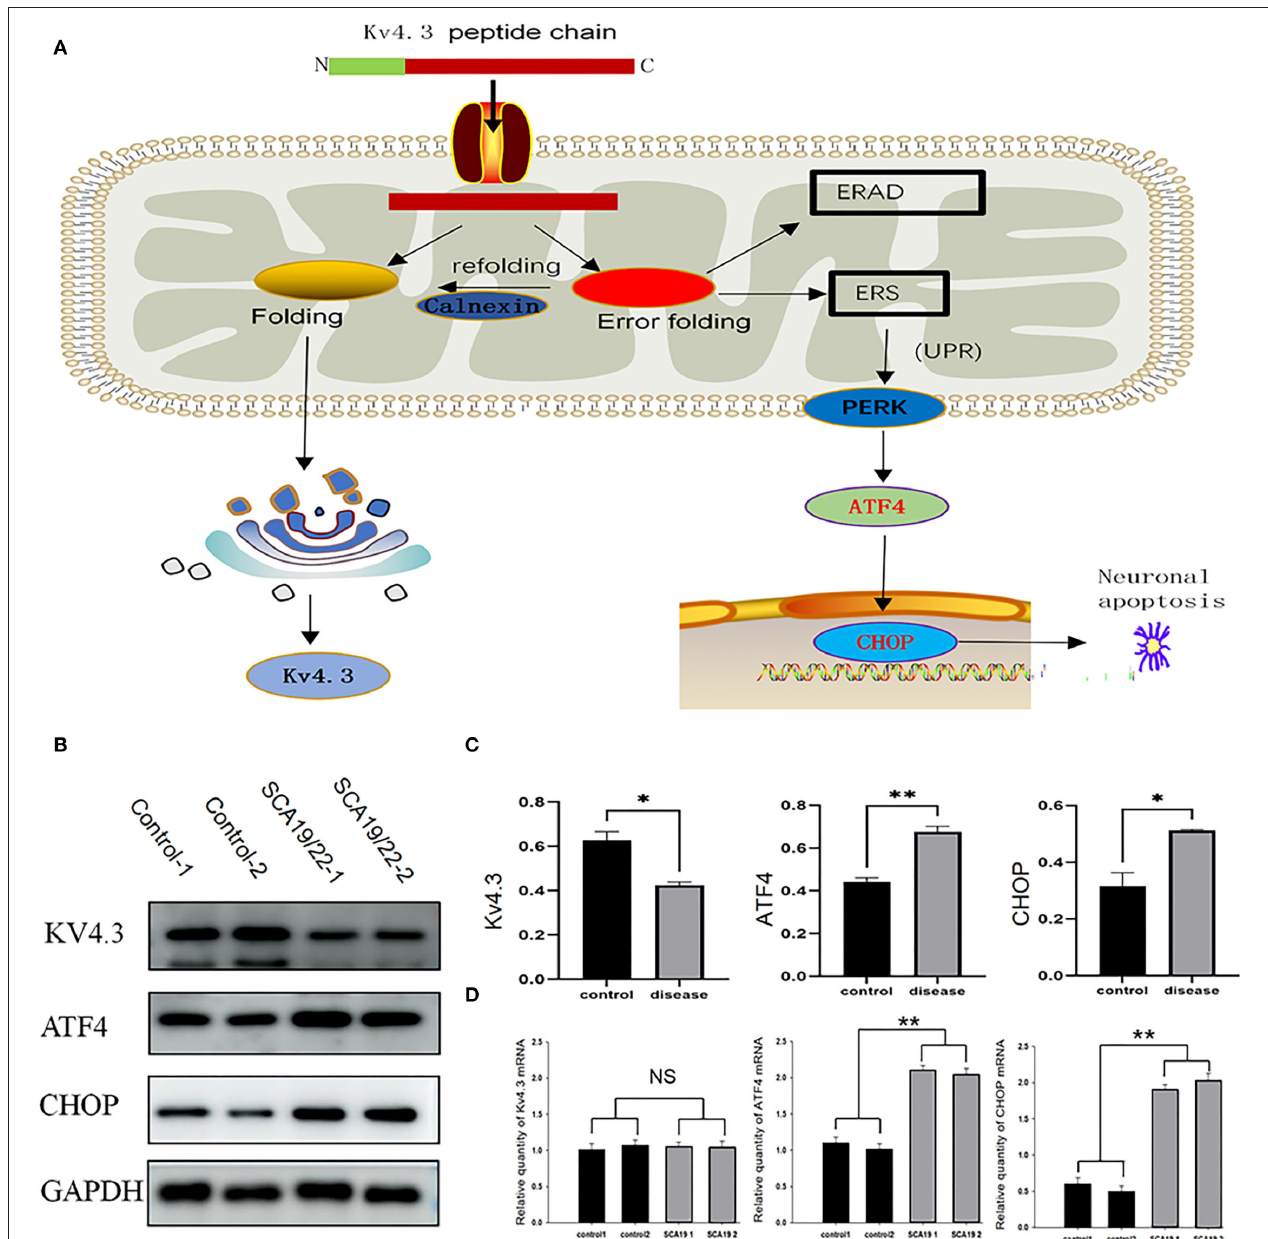
FIGURE 6 | (A) The mutant Kv4.3 instability increased and remained in the endoplasmic reticulum, which may activate the endoplasmic reticulum-associated degradation (ERAD) pathway and cause ERS. Increased expression of ATF4 and CHOP can eventually lead to neuronal death. (B) Total proteins derived from neurons were subject to immunoblotting analyses with the indicated antibodies. GAPDH expression was the loading control. (C) The Kv4.3, ATF4, and CHOP levels were quantified and normalized to the GAPDH. Western blotting showed that the c.1130 C > T (p.T377M) mutation of KCND3 led to a decrease in Kv4.3 protein compared with the healthy controls ( p < 0.05), while there was a significant increase in ATF4 and CHOP ( p < 0.05). (D) The mRNA levels of Kv4.3, ATF4, and CHOP were quantified and normalized to the GAPDH. RT-qPCR showed that the mRNA level of mutated KCND3 was not significantly different from that of the healthy controls. However, the mRNA levels of ATF4 and CHOP were significantly increased ( p < 0.05). Data are expressed as the mean ± SD; The significance was calculated using Student’s t -test (* p < 0.05; ** p <